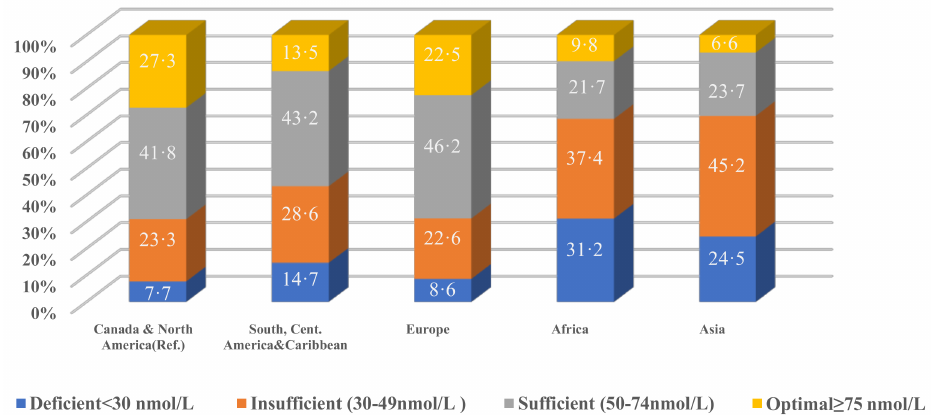
Figure A2. Weighted prevalence of S-25(OH)D status for immigrants by region of birth using Cycles 3 and 4 of Canadian Health Measures Survey data.